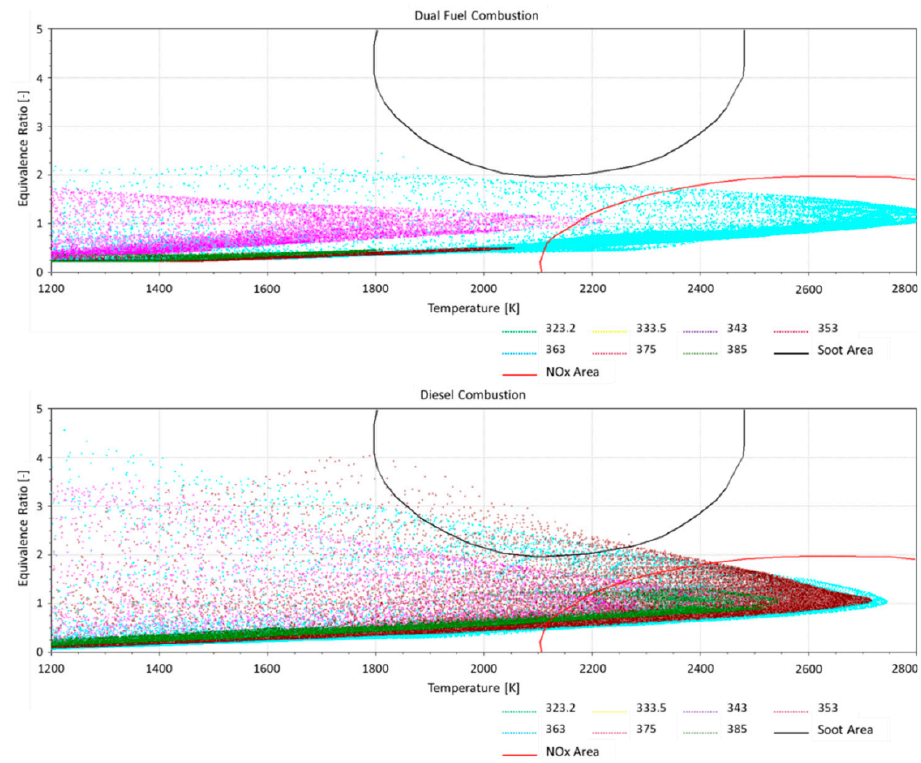
Figure 14. The NOx-Soot area according to the equivalence ratio—temperature